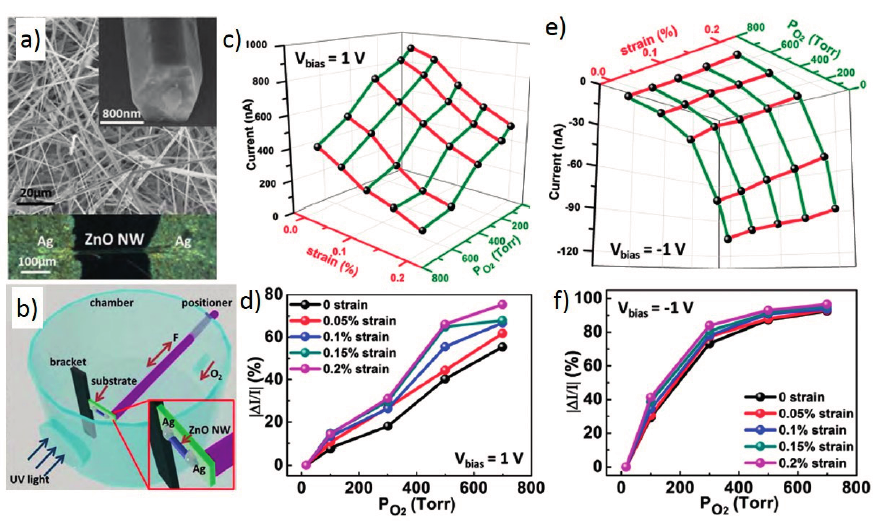
Figure 8. ZnO nanowire oxygen sensor and its performance. ( a ) SEM image of the as-synthesized ZnO nanowires. Inset image is a magnified view of a single wire. The bottom half is optical microscopy image of a typical ZnO nanowire oxygen sensor device; ( b ) Schematic of the measurement setup for studying the piezotronic effect in a ZnO nanowire oxygen sensor; ( c ) 3D graph depicting the current response under different strains and oxygen pressures at a bias of 1 V; ( d ) Magnitude of relative current change with oxygen pressure under different tensile strains from 0% to 0.2% at a bias of 1 V; ( e , f ) are corresponding results of ( c , d ) at a bias of − 1 V. Adapted from [24] with permission from John Wiley and Sons. Copy right